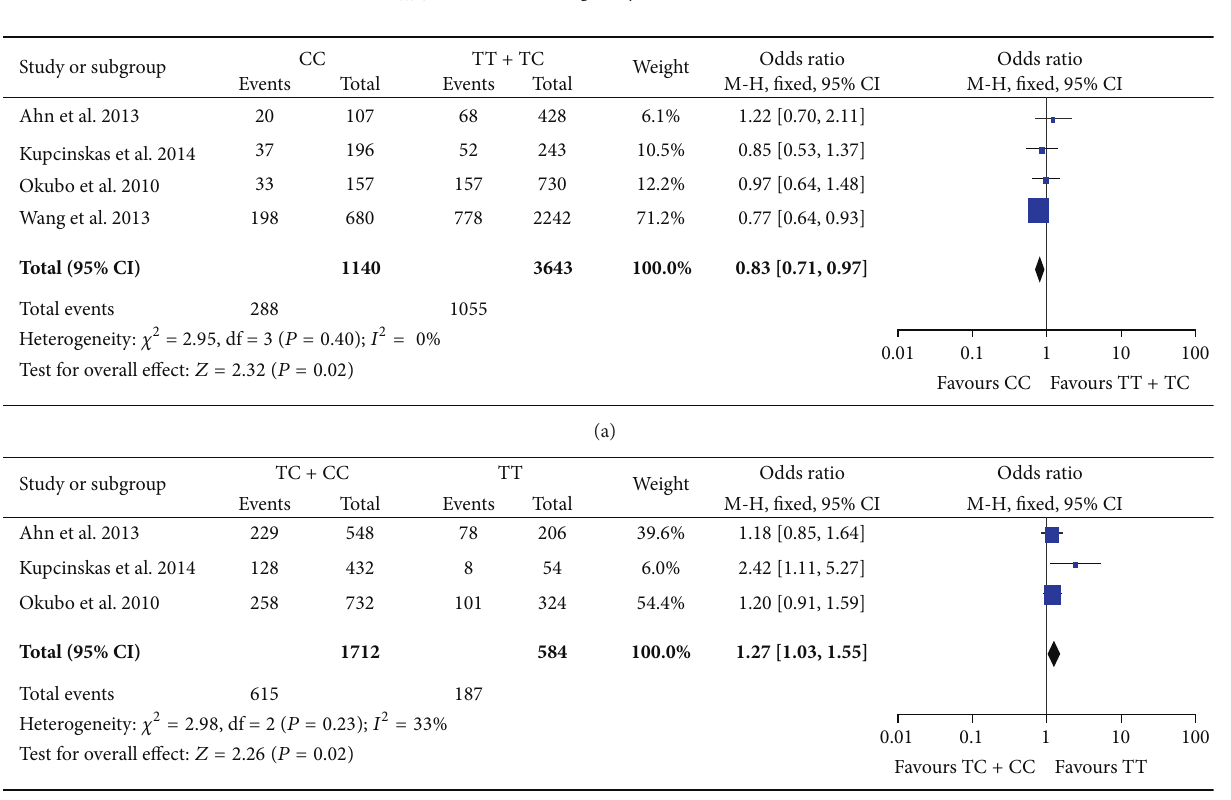
Figure 3: Forest plots of meta-analyses on rs11614913 in miR-196a2. (a) Subgroup analysis in diffuse type of gastric cancer using recessive model (CC versus TT + TC). (b) Subgroup analysis in intestinal type of gastric cancer under dominant model (TC + CC versus TT). The blue squares and corresponding horizontal lines indicate odds ratio of individual study. The area of the squares reflects weight of indicated study. The black filled diamond represents pooled odds ratio and 95% confidence